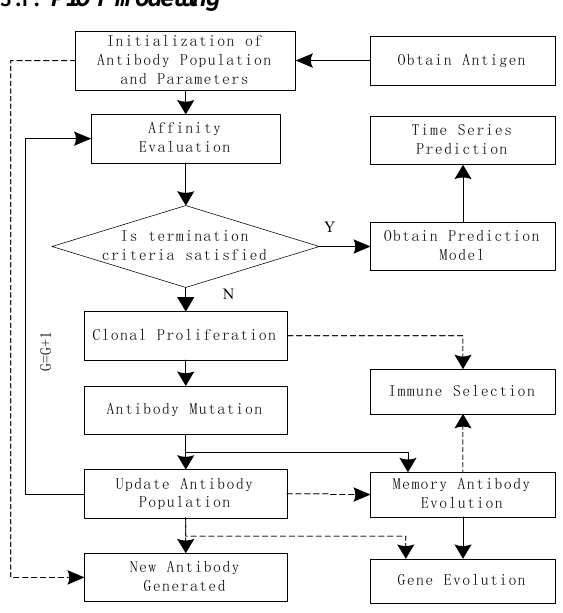
Fig. 1. The prediction modelling paradigm of PIOT. The prediction modelling paradigm of PIOT is shown in Fig.1. The function modules of PIOT mainly include initialization of antibody population and parameters, affinity evaluation, immune selection, clonal proliferation, antibody mutation, memory antibody and gene evolution etc. In Fig.1, the solid lines indicate the basic flowchart of prediction modelling; the dotted lines indicate the called relationship between both function modules, namely one function module linking with the arrow tail need to call another function module linking with the arrow head in modelling process. When affinity between antibody and antigen is reach to the termination condition of immune evolution, the prediction modelling process is stopped and the relevant prediction model is obtained. Thus, the modelling capability